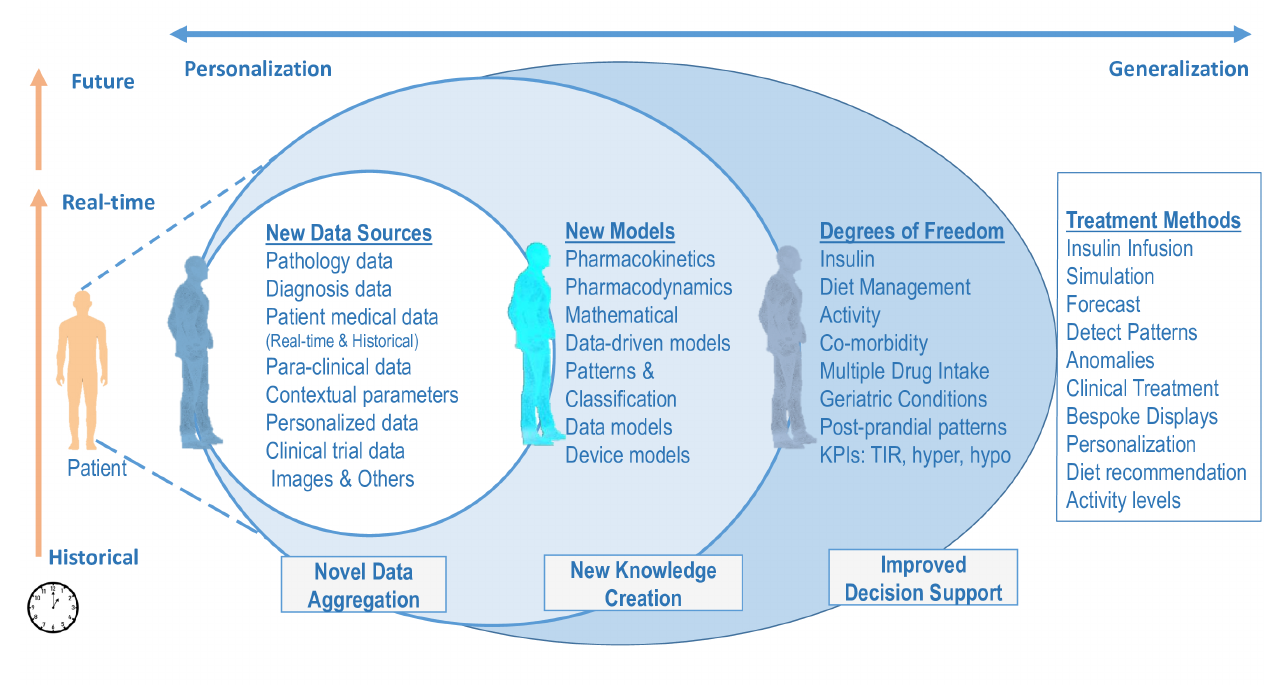
Figure 2. Precision Treatment Methods Through HDT—The HDT framework leads to new data, novel models that create additional knowledge, and improved decision support through new degrees of